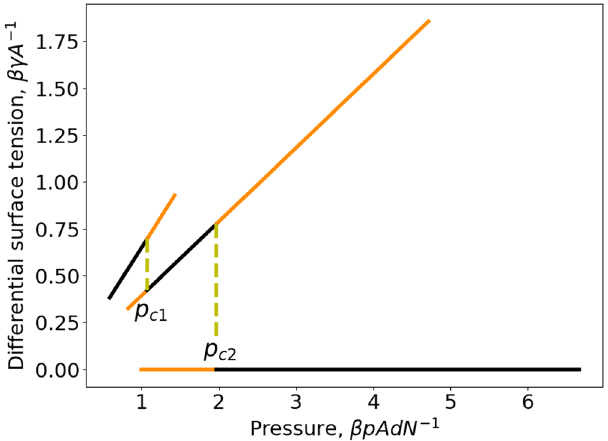
Fig. 6 | Differential surface tension as a function of pressure of an ideal gas con fi nedinaslitpore. Repulsivesquare-wellgas-wallpotential ð ε <0 Þ atareduced temperature, T =0 : 9525 ∣ ε ∣ k B (cid:1) 1 ð e βε =0 : 35 Þ . The large-pore branch is the left one with the thermodynamically stable states on the black part and metastable states on the orange part ð p > p c 1 Þ . The intermediate-pore branch is the middle one with thethermodynamicallystablestatesontheblackpartandmetastablestatesonthe twoorangeparts( p < p c 1 or p > p c 2 ).Thesmall-porebranchistherightonewiththe thermodynamically stable states on the black part and metastable state on the orange part ð p < p c 2 Þ